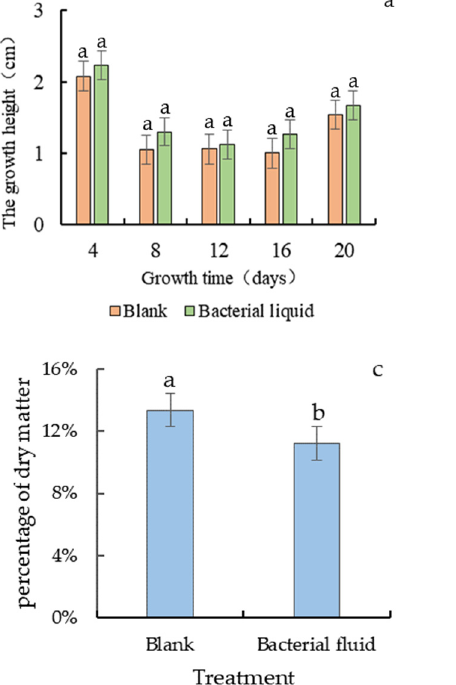
Figure 2. Plant height of Chinese cabbage at different growth times ( a ), biomass ( b ) and percentage of dry matter ( c ) of Chinese cabbage at harvest time (20 days). Different letters in the same column indicate statistically significant differences among the samples based on one-way ANOVA (LSD, p < 0.05).